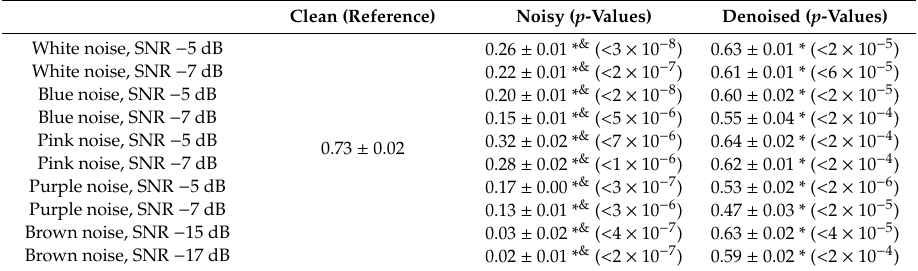
Table 3. Ratio of power for clean, noisy, and denoised sequences and the p -values.